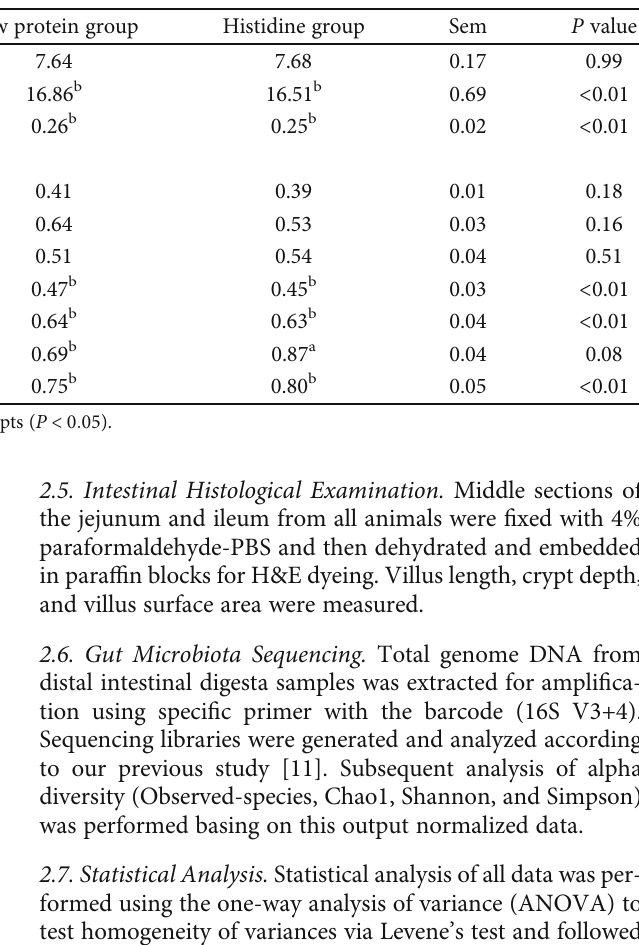
Table 1: E ff ect of dietary histidine on growth performance in low protein diet-fed